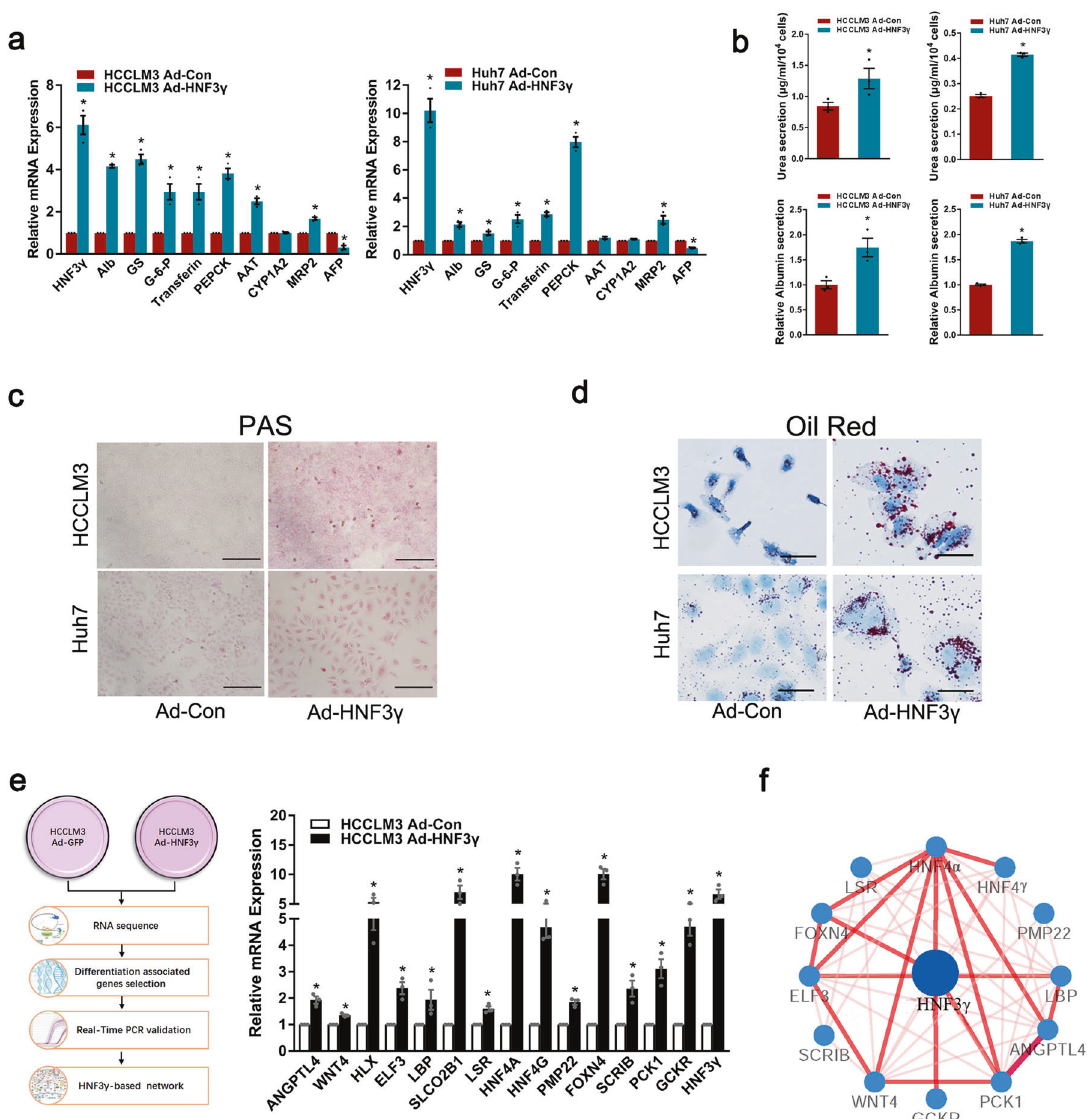
Fig. 4 HNF3 γ promotes the differentiation of HCC cells. a The expression of hepatocyte-speci fi c genes and AFP in HCCLM3 or Huh7 cells infected with Ad-HNF3 γ or Ad-Con was determined by real-time PCR. b Urea concentration in the supernatant of HCCLM3 or Huh7 cells was measured using a QuantiChrom TM Urea Assay Kit (upper). The ALB secretion ability of HCC cells was measured as indicated using a Human Albumin ELISA Quantitation kit (lower). Results were expressed as means ± SEM. c The glycogen storage ability of HCCLM3 or Huh7 cells was evaluated by Periodic-Acid Schiff (PAS) staining. Scale bars, 100 mm. d The lipid accumulation ability of HCCLM3 or Huh7 cells was examined by oil red O staining (Sigma-Aldrich). Scale bars, 400 mm. e Hepatocyte differentiation-associated genes differentially expressed in HNF3 γ - overexpressing HCCLM3 cells were obtained by RNA-seq and validated by real-time PCR. f HNF3 γ -centered regulatory network that includes 12 liver differentiation or metabolism-associated transcription factors and functional molecules. The thickness and brightness of lines indicate the correlation degree between distinct